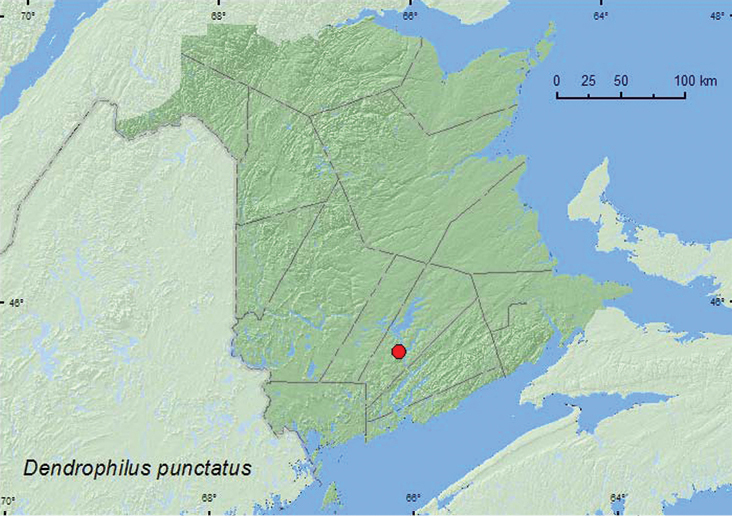
Collection localities in New Brunswick, Canada of Dendrophilus punctatus.